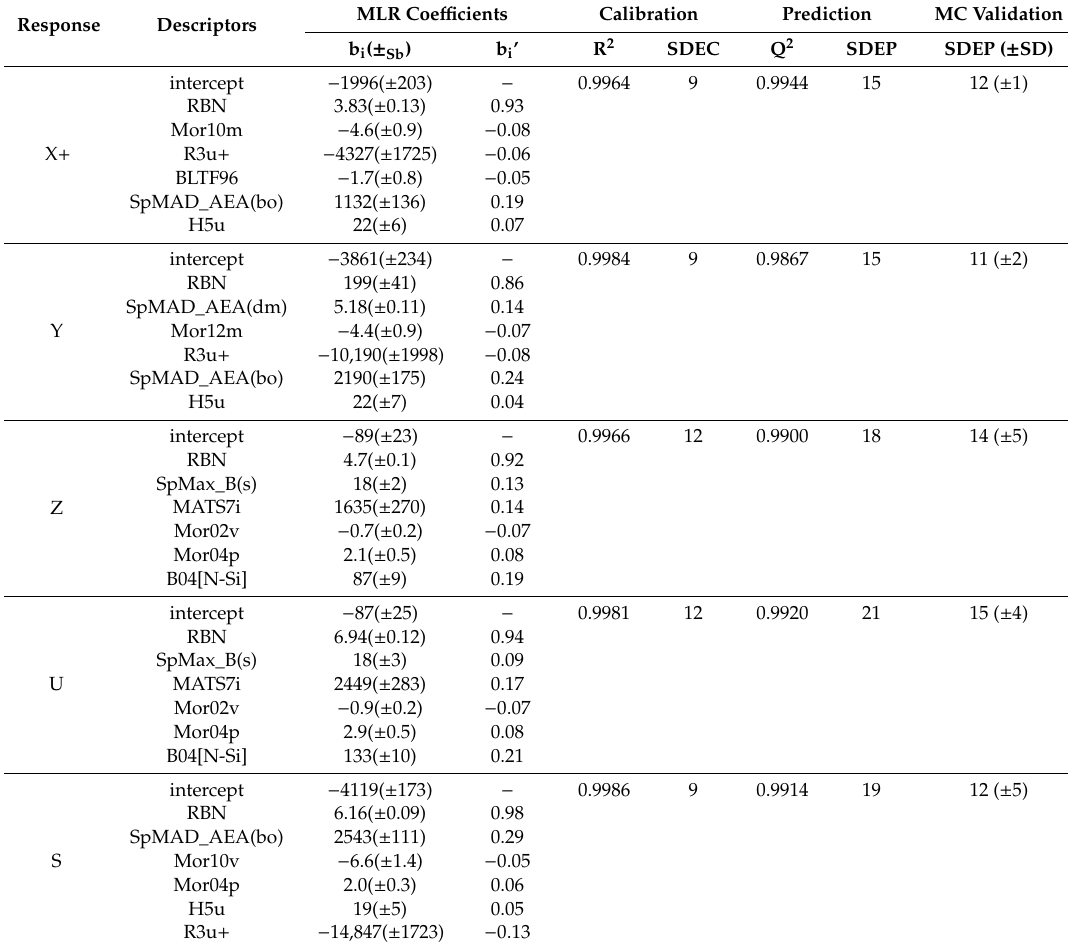
Table3. Significantmoleculardescriptorsoftheestablishedquantitativestructure–retentionrelationship (QSRR) models, multilinear regression (MLR) coe ffi cients (b) and related standardised values (b’); descriptive and predictive performance evaluated on the external prediction set and by Monte Carlo (MC) validation.